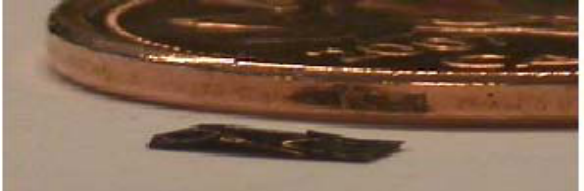
Figure 5. Thin film SiCN of thickness 32 micron next to a Canadian cent for size comparison.